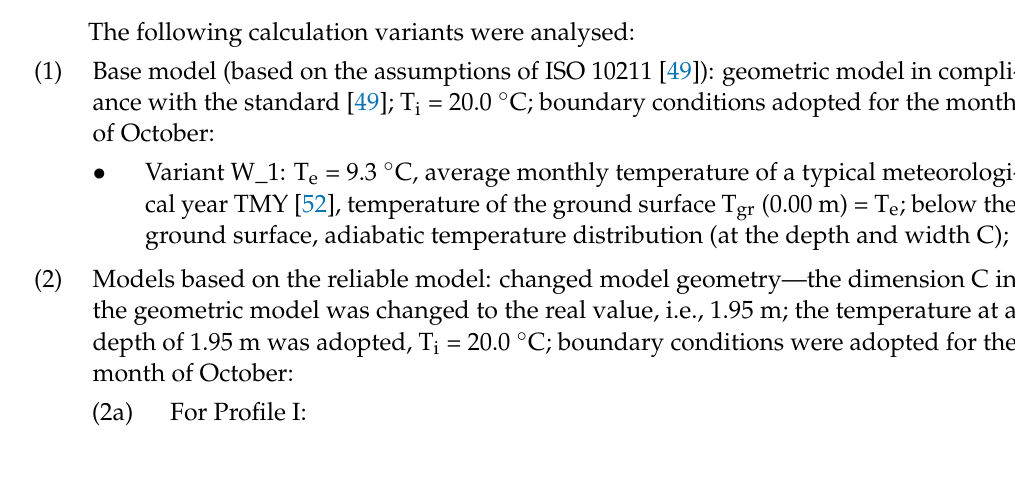
Figure 2. Geometry of the model.